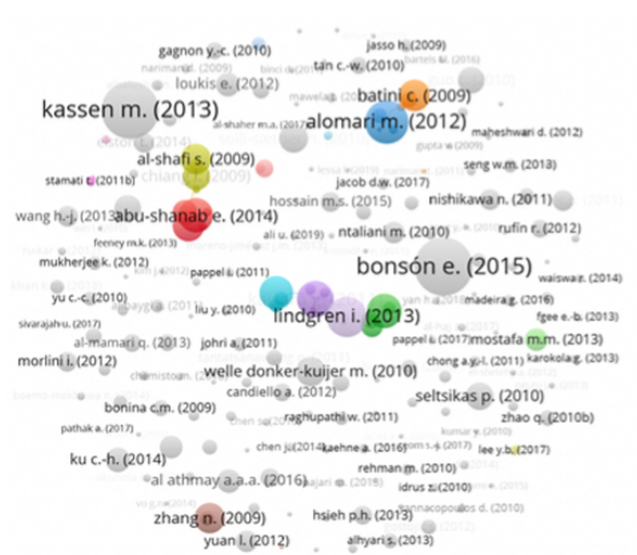
Figure 5. Co-citation of publications in the documents